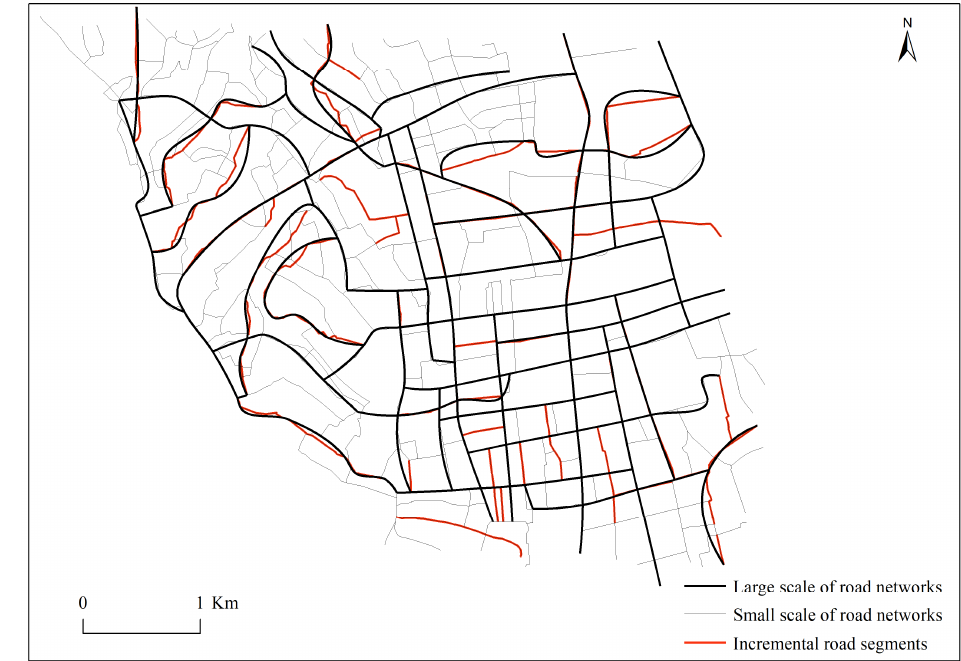
Figure 6. Road network data of study area.